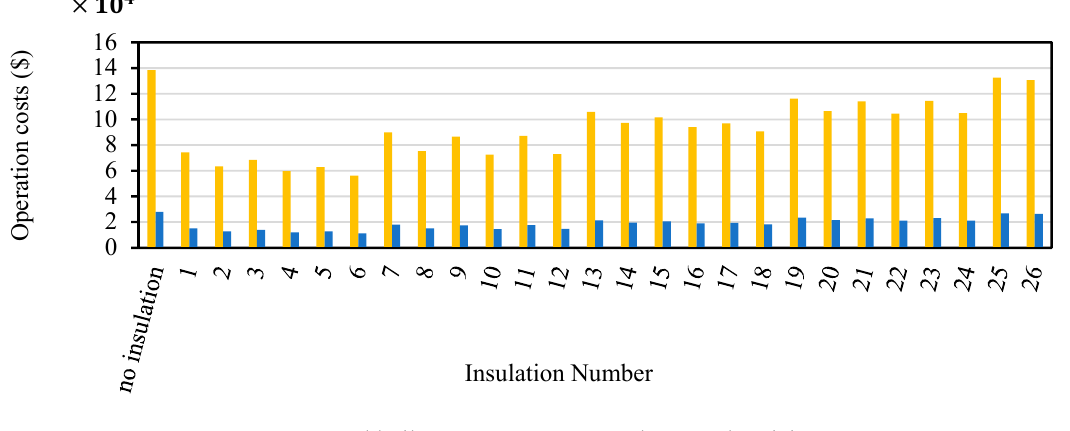
Figure 18. Comparison of the annual gas and electricity cost for different insulation scenarios based on Table 5.